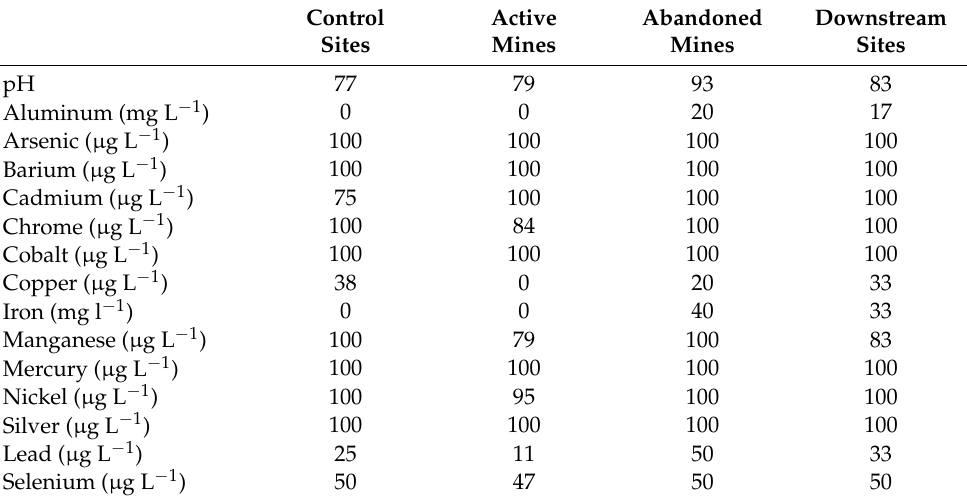
Control Active Abandoned Downstream Sites Mines Mines Sites